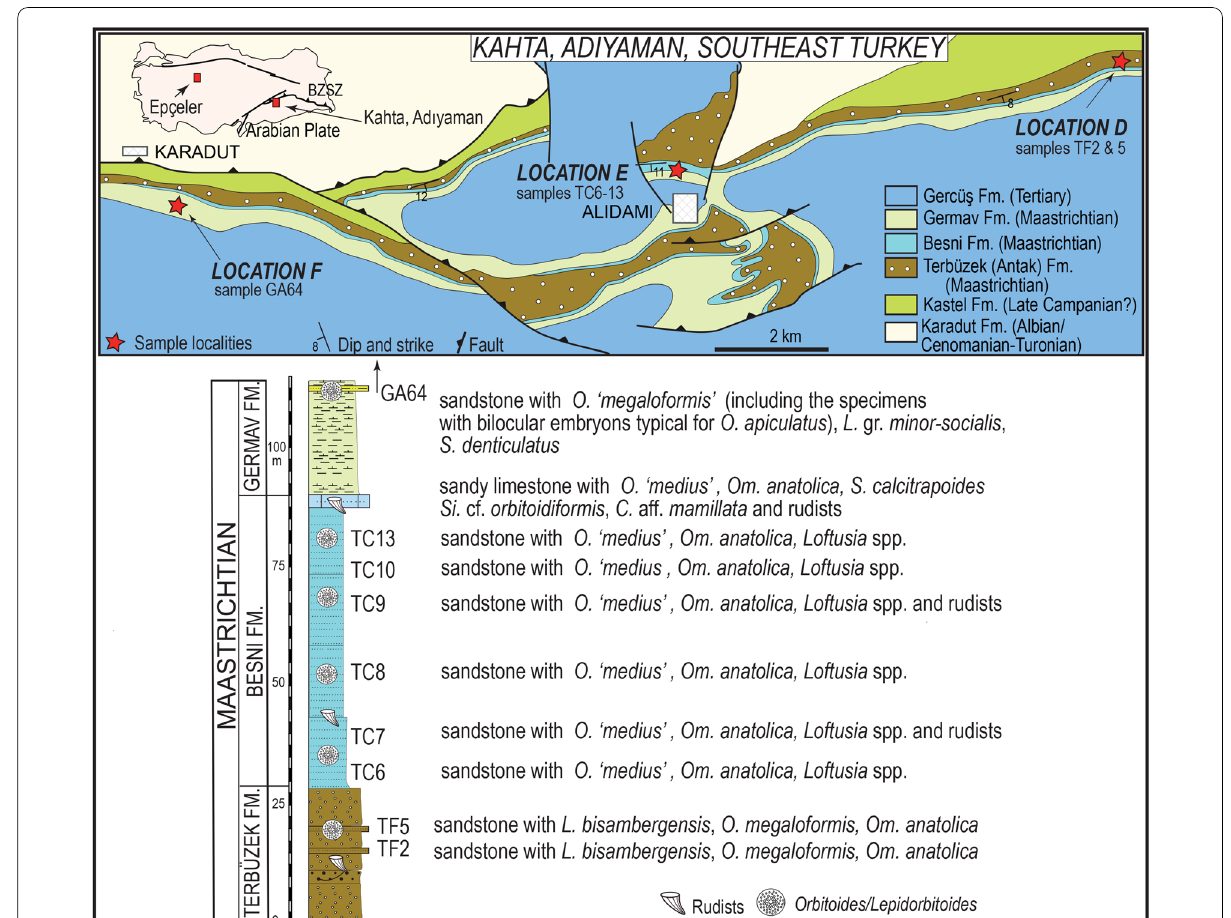
Fig. 4 Simplified geological map of the Kahta, Adıyaman region in SE Turkey (after Özcan, 1994) and a composite lithostratigraphic log of the Terbüzek, Besni and Germav Formations with positions of the